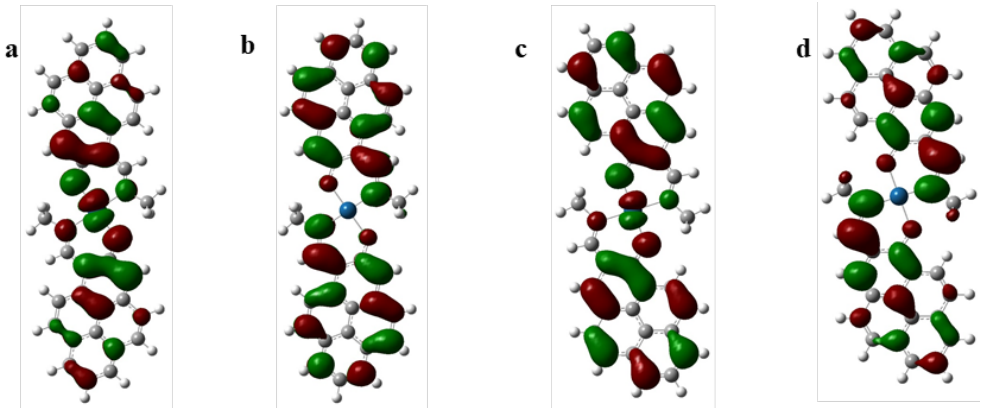
Figure 4. Plots of the ( a ) HOMO of 2(Pt) , ( b ) LUMO of 2(Pt) , ( c ) HOMO of 1(Pt) , and ( d ) LUMO of 1(Pt) obtained from the RB3LYP / 6-31g(d) level for C, H, O, N elements and LanL2DZ for Pt element. All the MO surfaces correspond to an isocontour value (0.02 a.u.).